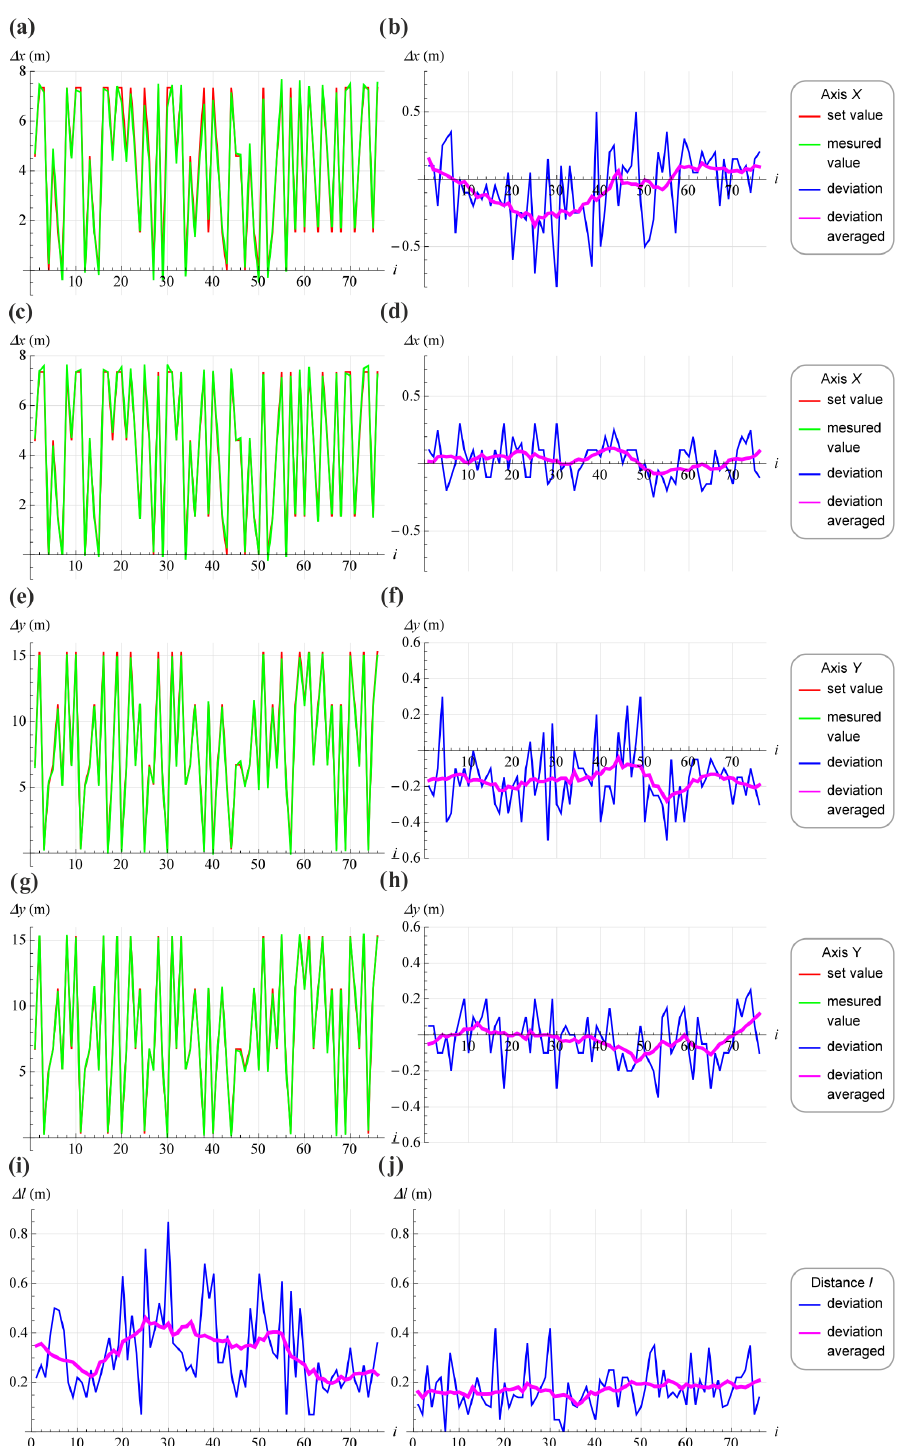
Figure 13. Accuracy measurement in every 76 attempts, where the robots reached the aim point. ( a , e ) Differences between set (red) and reached (green) positions in x and y directions, when the vision system was off. ( c , g ) In those graphs the vison system was turned on. ( b , f ) Point deviations and average line (pink) in x and y directions, where the vision system was turned off. ( d , h ) The vision system was turned on. ( i , j ) Shows position inaccuracies, respectively with the vision system off and